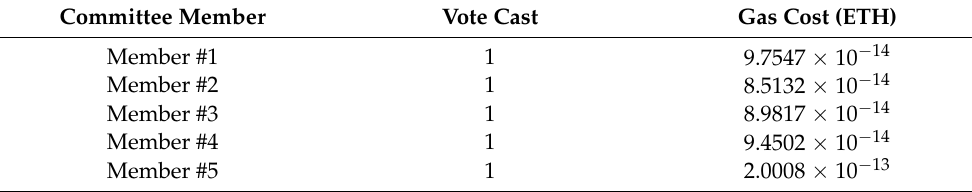
Table 5. Majority voting votes and gas costs.